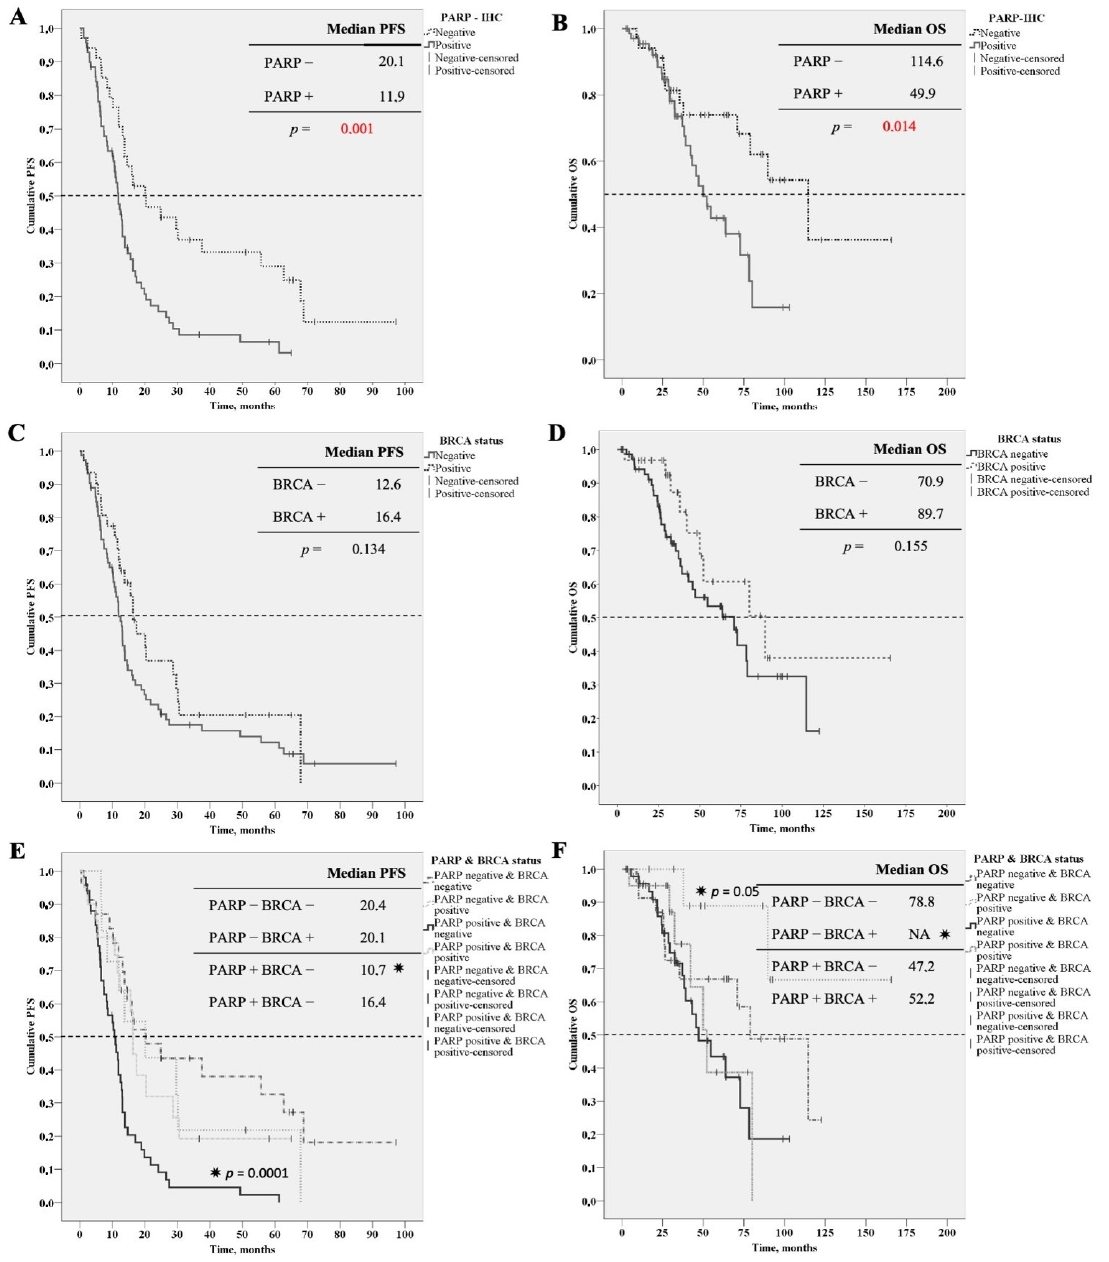
Figure 1. Survival curves (Kaplan–Meier curves, log-rank test). ( A ) Progression free survival curves of PARP negative and positive patients. ( B ) Overall survival curves of PARP negative and positive pacients. ( C ) Progression free survival curves of BRCA negative and positive patients. ( D ) Overall survival curves of BRCA negative and positive patients. ( E ) Progression free survival curves of PARP negative and positive pacients stratified for BRCA status. ( F ) Overall survival curves of PARP negative and positive pacients stratified for BRCA status. * assigned to curve which significantly differed from the others.